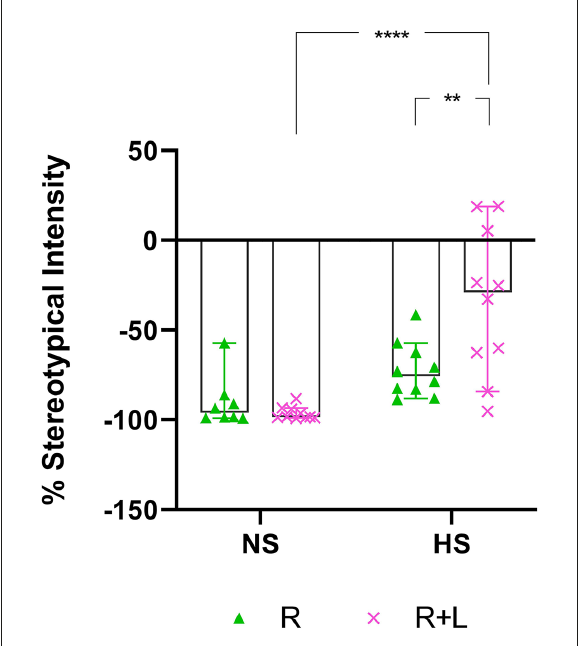
FIGURE3 Two-hour post-R stereotypical intensity shown by NS and HS animals in the R and LOR+R groups. 2-way ANOVA followed by Bonferroni’s multiple comparisons tests. Data represent the median ± 95CI. ** p < 0.01; **** p < 0.0001; R, behavioral restriction; LOR+R, lorazepam combined with behavioral restriction; NS, non-stereotypical; HS, high stereotypical.